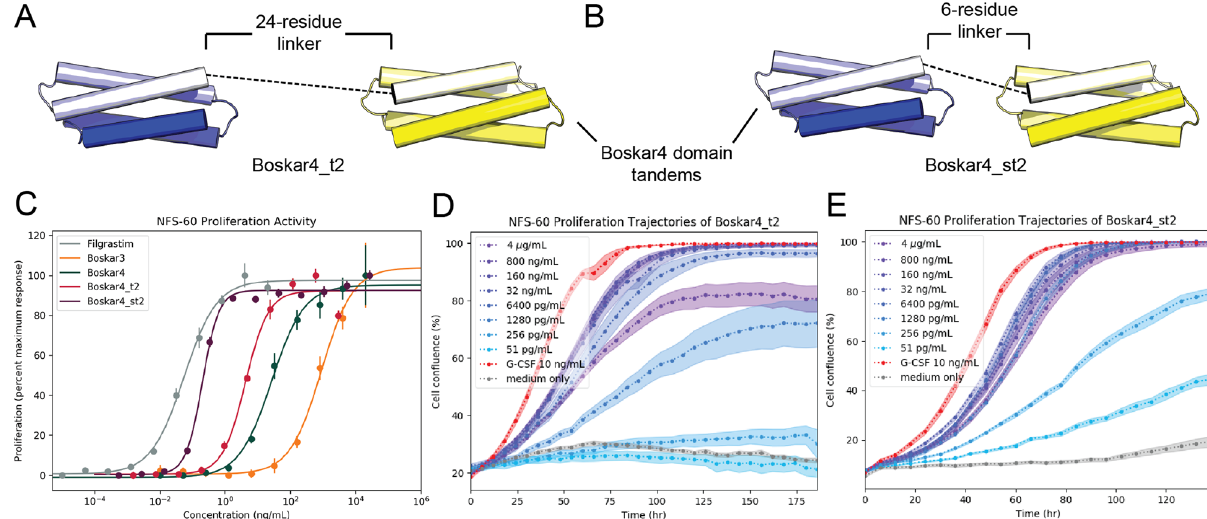
Fig. 6 The potency of designs can be greatly enhanced by the optimal tandem spacing. The creation of two-copy Boskar4 tandems with different fl exible spacers, through A a 24-residue-linker (Boskar4_t2), and B a short 6-residue-linker (Boskar4_st2). C Dose – response curves in NFS-60 cells show Boskar4_t2 (EC 50 = 180 pM), and Boskar4_st2 (EC 50 = 7.6 pM) to be 11- and 263-fold more active than the single domain Boskar4, respectively. Datapoints and error bars represent mean ± standard deviations of 3 biologically independent replicates. D , E This greatly enhanced potency is also evident in the dose- and time-dependent NFS-60 proliferation kinetics, highlighting the requirement for an optimal G-CSFR dimerisation spacing to achieve maximal G-CSFR activation. The experiments in C , E were performed as described in fi gure legend to Fig.